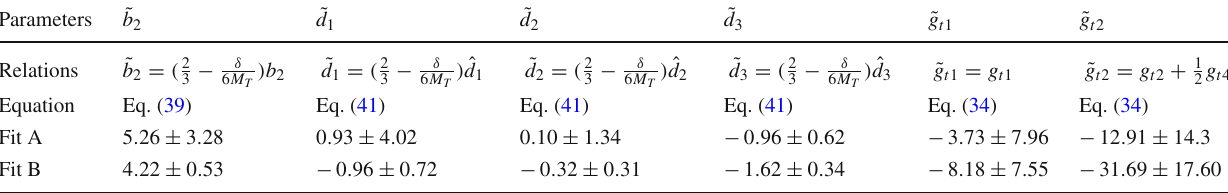
Table 2 The 6 parameters to be fitted